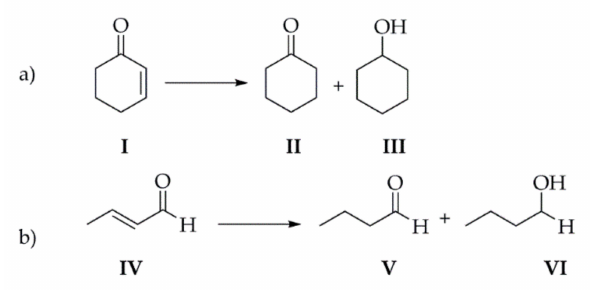
Figure 1. Catalytic reaction pathways of ( a ) 2-Cyclohexen-1-one, ( b )